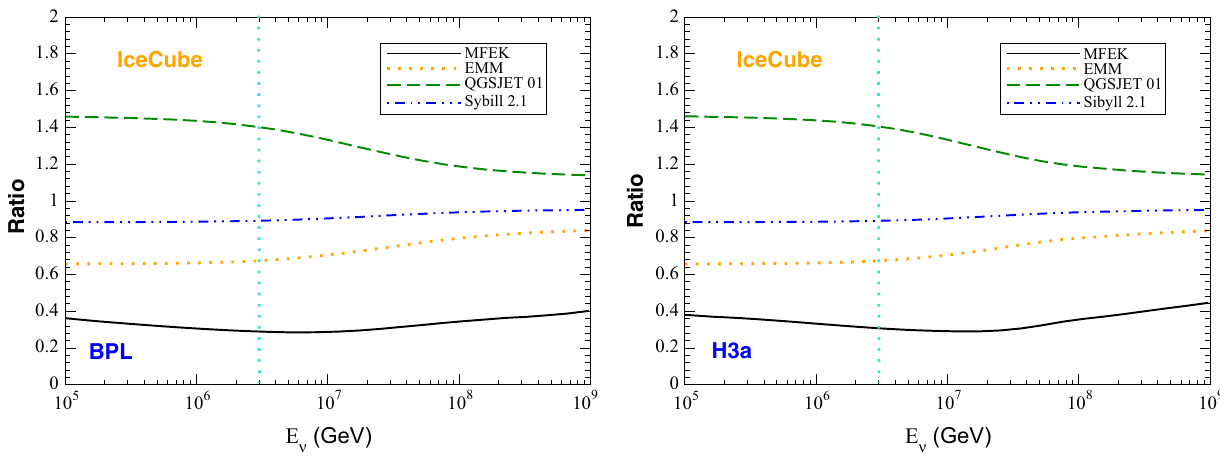
Fig. 2 Energy dependence of the prompt neutrino flux, normalized by a factor E 3 ν , calculated assuming the BPL (left) and H3a (right) models for the primary cosmic ray flux and different models for the inelastic proton–air cross section